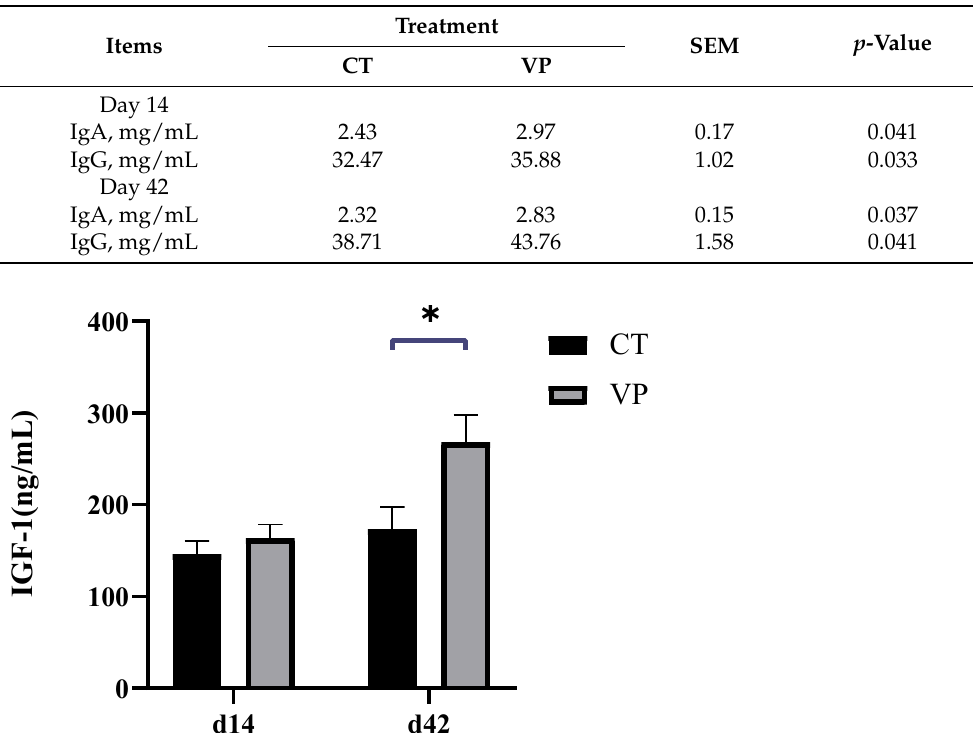
Table 4. Effect of dietary supplementation with stimbiotics on plasma immunoglobulin of weaned piglets.